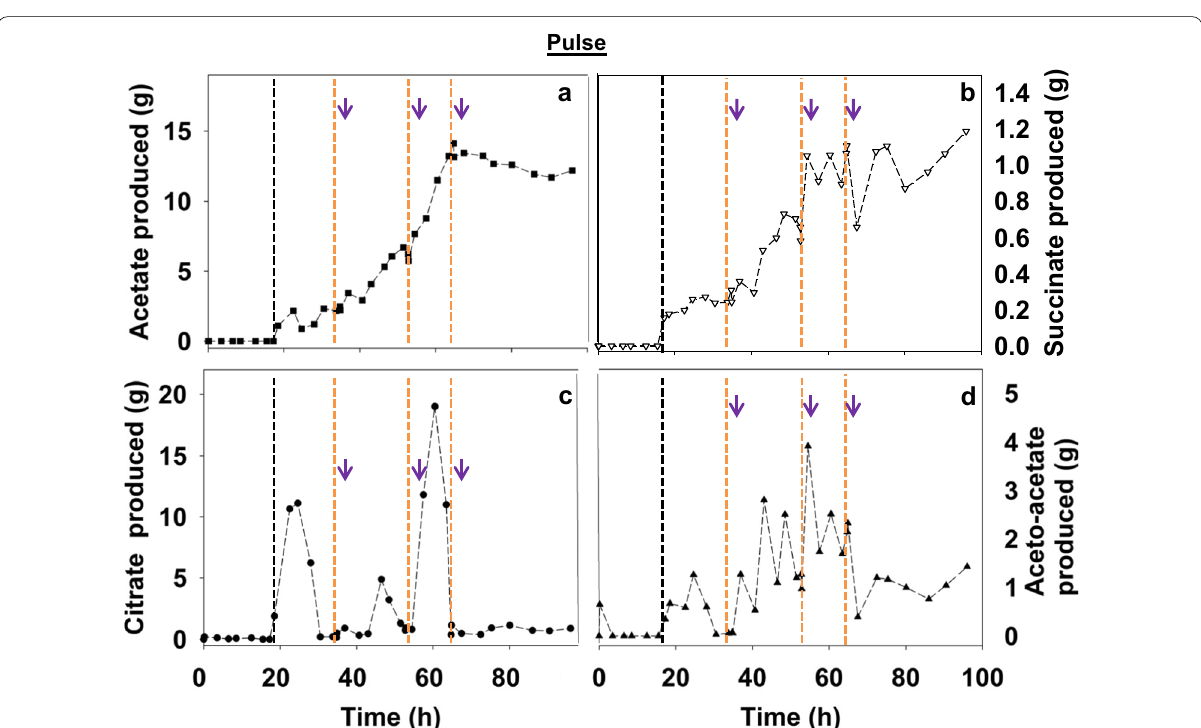
Fig. 2 Organic acids production during fructose pulses: acetate ( a : ■ ), succinate ( b : ▽ ), citrate ( c : ● ), and aceto-acetate ( d : ▲ ). Black vertical lines represent the beginning of the fed-batch phase and orange vertical lines represent fructose pulses. Purple arrows represent additions (kanamycin, 100 mg L − 1 ; elements and phosphorus ·